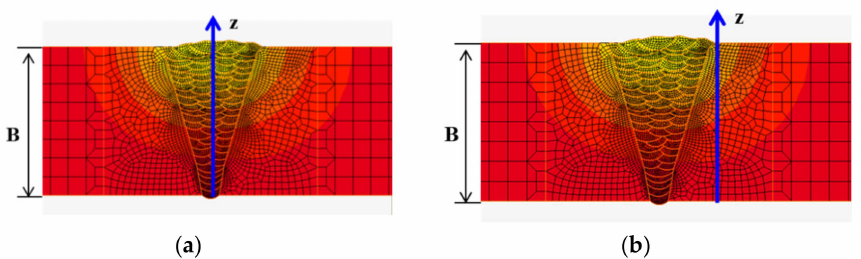
Figure 15. Prediction position at the center and the toe parts of the weld: ( a ) welding center and ( b ) welding